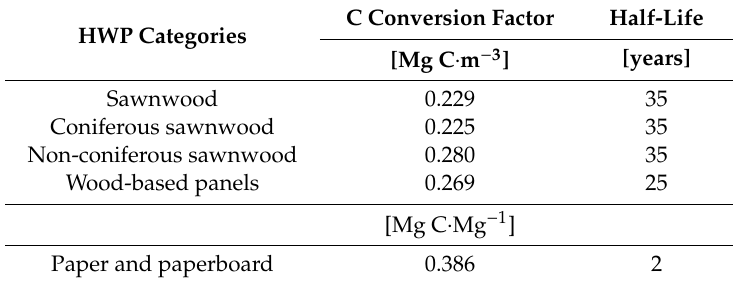
Table 4. Carbon conversion factors and half-lives used in modelling.